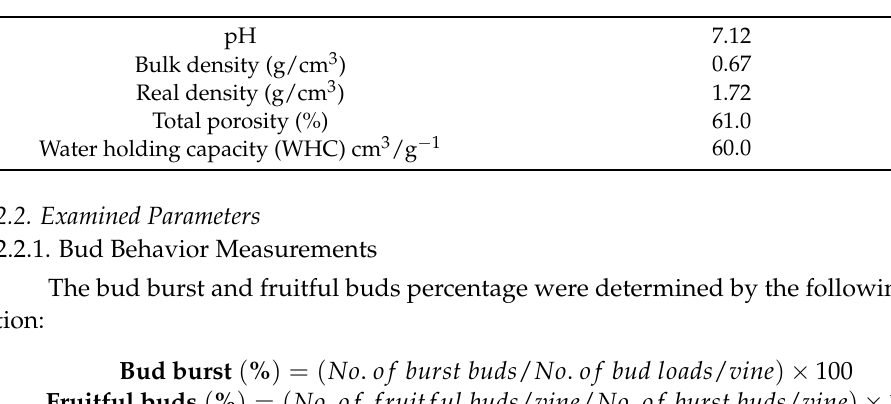
Table 3. Several features of the studied